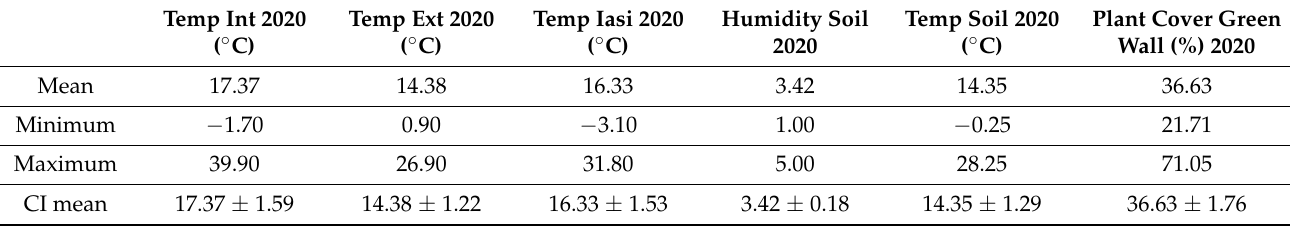
Table 1. Characteristics measured in 2020.